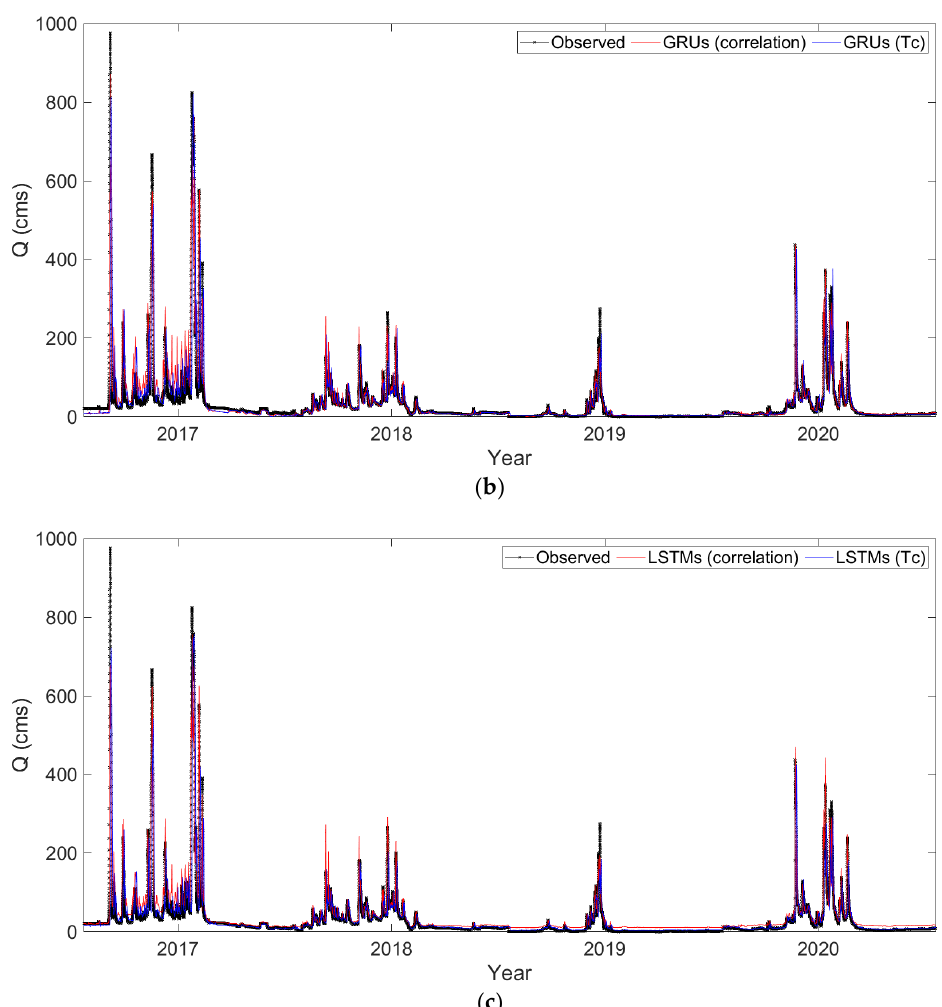
Figure 6. The comparison of observed discharge and 12-h predicted discharge using deep learning model for the Leoi River basin ( a ) RNNs ( b ) GRUs and ( c ) LSTMs.